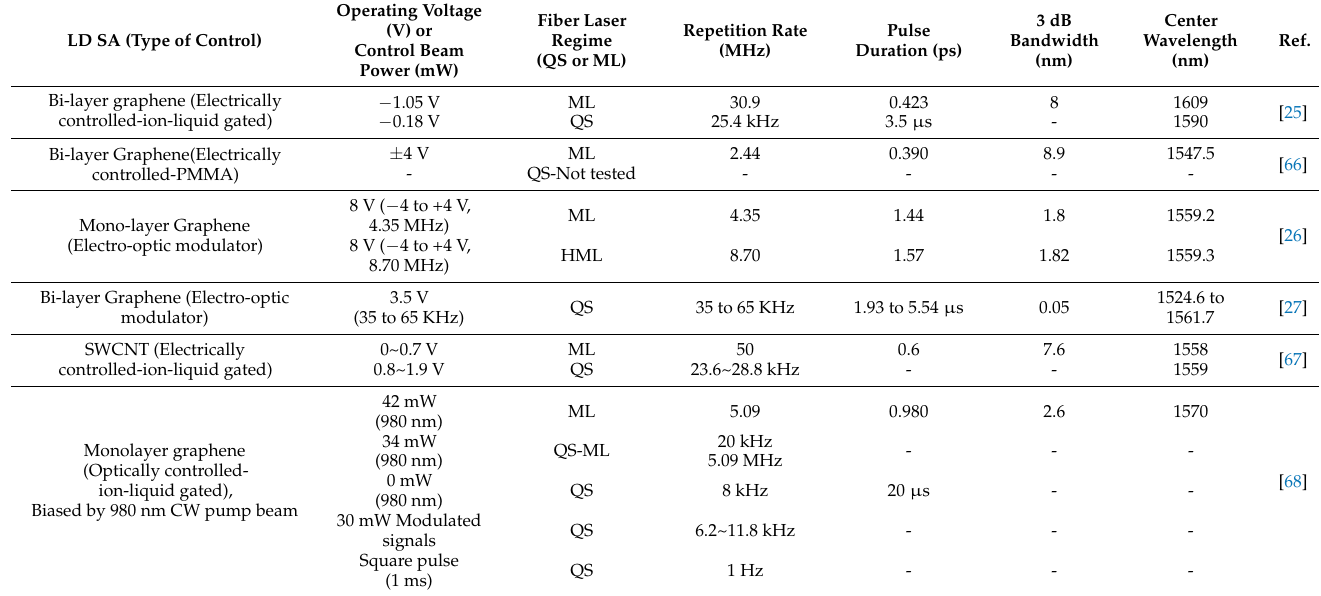
Table 2. Performance summary of Externally controlled LD SA for tunable fiber